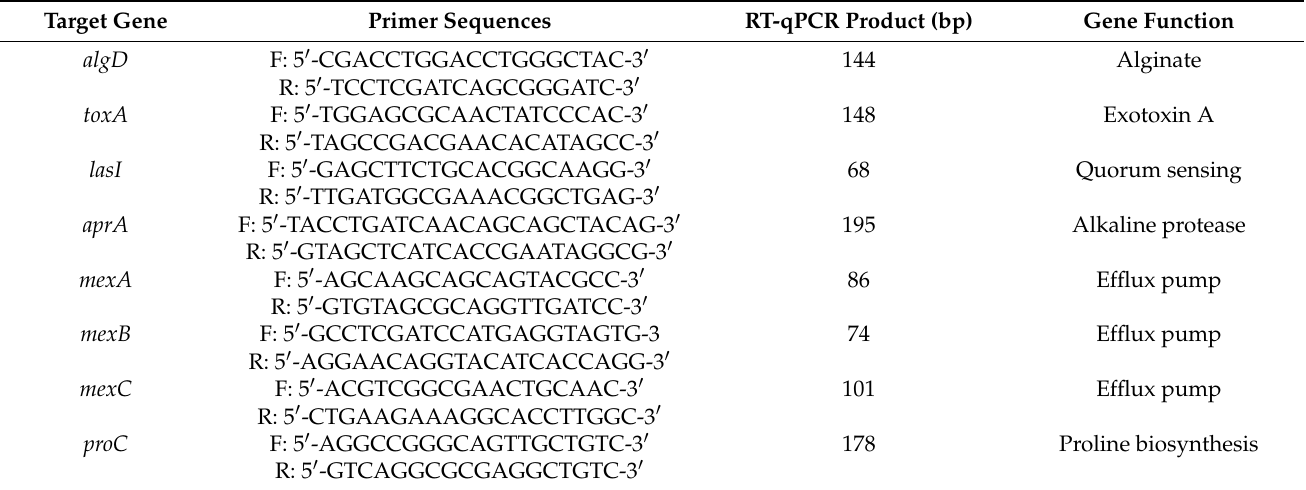
Table 5. Primer sequences used in real-time reverse transcription quantitative PCR analyses. The expression of selected virulence genes by P. aeruginosa PaPh32 was evaluated after 20 h of exposure to FDA-approved drugs by real-time RT-qPCR using oligonucleotides designed on the sequence of